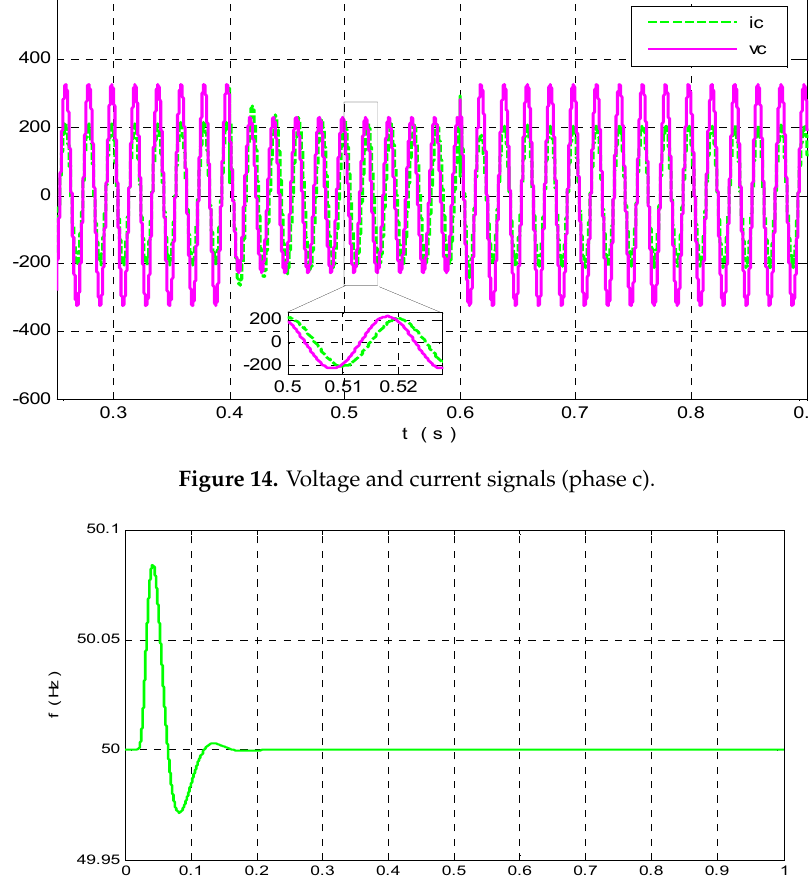
Figure 15. The simulation of the frequency of the proposed system.